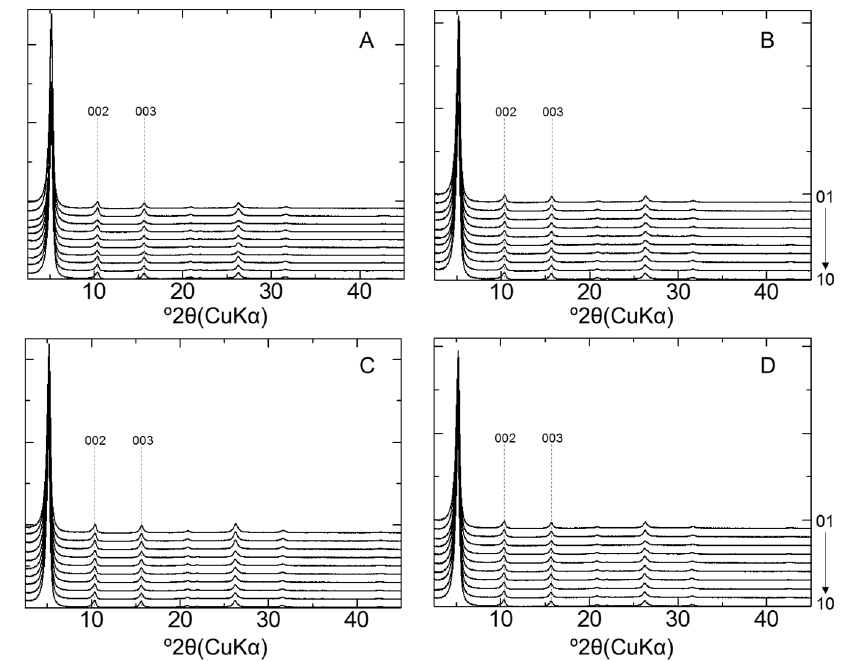
Figure 8. XRD patterns of montmorillonite after ethylene glycol (EG) treatment. ( A ) LAC-MX_4.9 y, ( B ) LAC-MX_10 y, ( C ) OPC-MX_4.9 y, and ( D ) OPC-MX_10 y. Sample IDs are arranged 1–10 from the top to bottom of each figure.